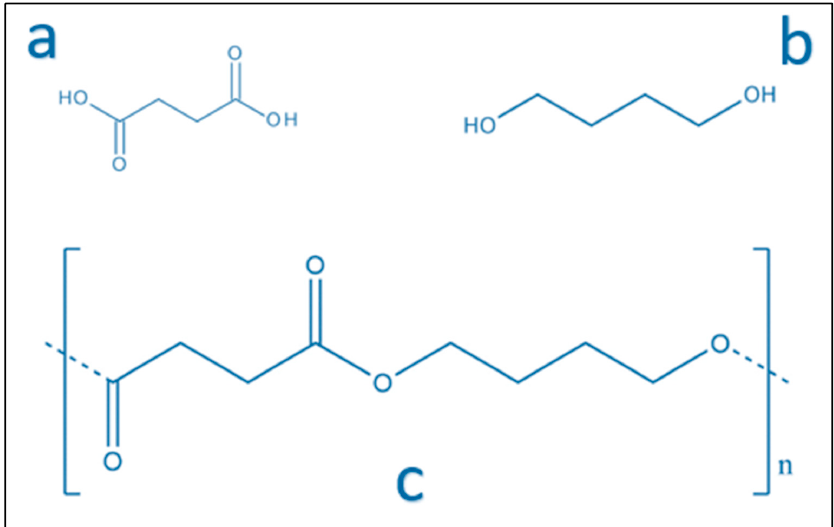
Figure 1. Chemical structure of ( a ) succinate acid, ( b ) 1,4-butanediol, and ( c ) poly(butylene succinate) (PBS).